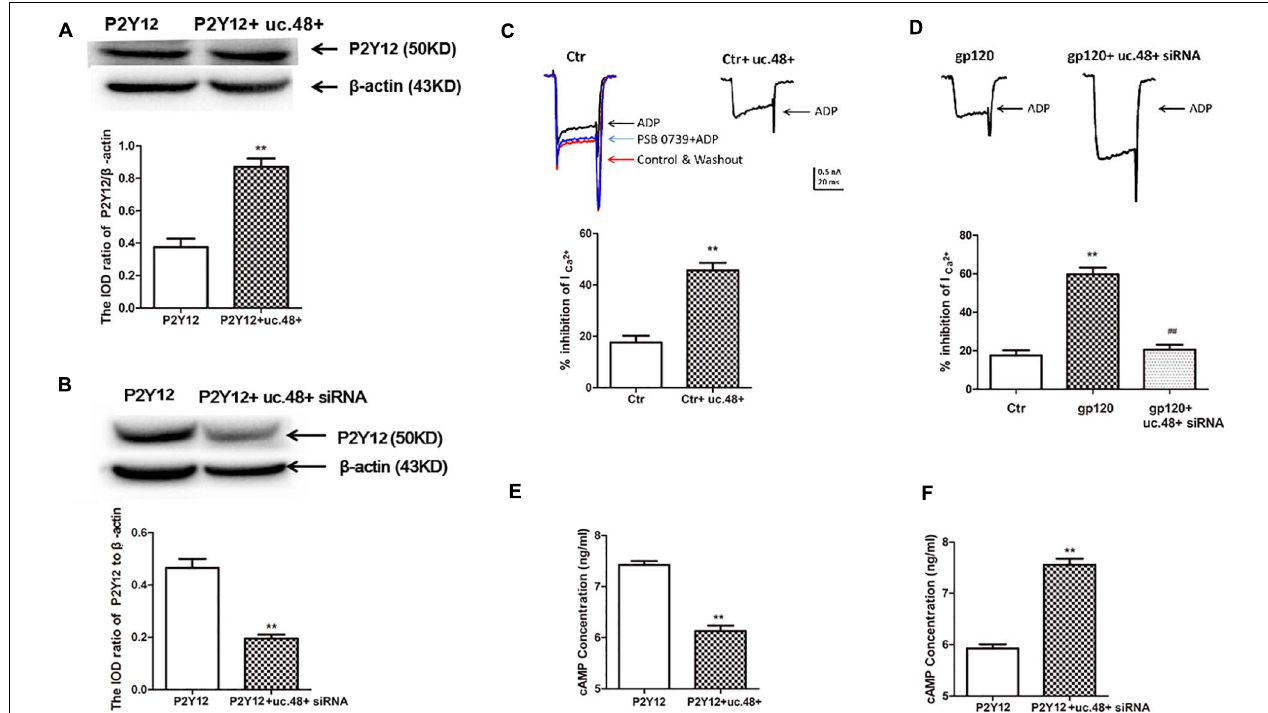
FIGURE 6 | LncRNA uc.48+ positively regulated expression and activity of P2Y12 receptor. (A) P2Y12 protein content co-transfected with P2Y12 and uc.48+ plasmids was increased compared with transfected with P2Y12 plasmid alone in HEK293 cells. (B) P2Y12 protein content co-transfected with P2Y12 plasmid and uc.48+ siRNA was decreased in HEK293 cells. n = 6 independent cultures. Data are displayed as means ± SEM. ∗∗ p < 0.01 vs. P2Y12 plasmid alone group. (C,D) Effects of uc.48+, gp120, and uc.48+ siRNA treatment on voltage-gated Ca 2 + current mediated by P2Y12 receptor agonists in neurons. n = 12 independent cultures. Data are displayed as means ± SEM. ∗∗ p < 0.01 vs. control group, ## p < 0.01 vs. gp120 treatment group. (E,F) ADP-induced intracellular cAMP levels were measured in HEK293 cells. n = 5 independent cultures. Data are displayed as means ± SEM. ∗∗ p < 0.01 vs. P2Y12